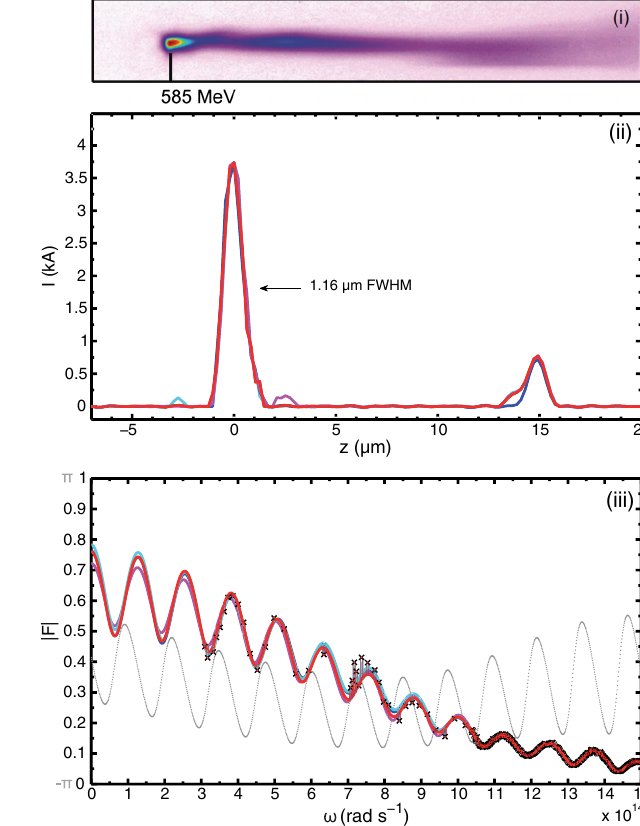
FIG. 9. Reconstruction of longitudinal bunch profile from ex- FIG. 10. Reconstruction of longitudinal bunch profile from ex- perimentally measured CTR spectrum: (i) image of Lanex screen perimentallymeasuredCTRspectrum:(i)imageofLanexscreenat at the exit of the electron spectrometer; (ii) ten reconstructed the exit of the electron spectrometer; (ii) ten reconstructed profiles, profiles, the most representative of which is colored red; the most representative of which is colored red; (iii) measured (iii) measured spectrum (thick black line, black crosses) and spectrum (thick black line, black crosses) and reconstructed reconstructed spectra (colored lines), including retrieved phase spectra (colored lines), including retrieved phase of most repre- of most representative profile (gray dots). Data for Shot 2168: ¼ sentativeprofile(graydots).DataforShot2147: P ¼ 82mbar ( n e ¼ 4 : 0 (cid:7) 10 18 cm (cid:2) 3 ); L cell ¼ 14 mm ; E peak ¼ P ¼ 82 mbar ( n 13mm ; E 585 (cid:3) 48MeV ; Q 4 : 0 (cid:7) 10 18 cm (cid:2) 3 ); L e cell ¼ peak ¼ peak ¼ 599 (cid:3) 47 MeV ; Q 3 : 8 pC ; Q 22 : 5 pC . peak ¼ total ¼ 21 : 0pC 2 : 8pC ; Q total ¼